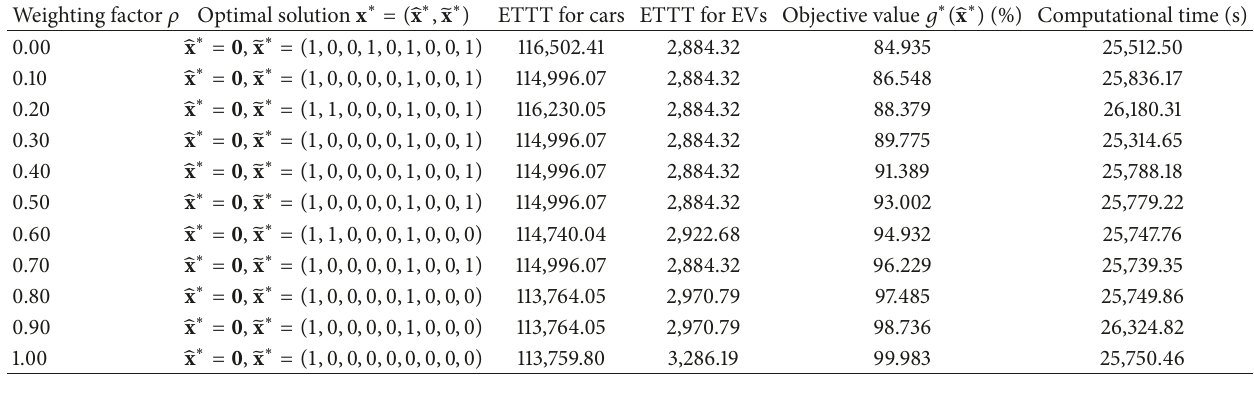
Table 6: The outcomes for the inverse-direction EV-NDP schemes.